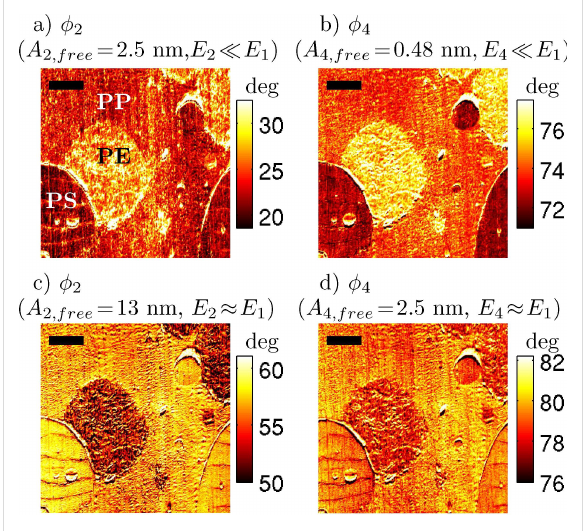
Figure 2: Using the same cantilever and sample from Figure 1, the imaging modes are compared at different energy levels. In the top row (a, b) the first eigenmode has a larger energy than the higher mode (2nd or 4th respectively). In the bottom row (c, d), the first eigenmode energy is comparable to the higher eigenmode energy. In the top row, the PE has the highest phase lag, whereas in the bottom row the PE has the lowest phase lag. This shows that the contrast reversal observed in Figure 1 is not caused by the choice of eigenmode alone, but by the energy in the eigenmode. The scale bar is 2 μ